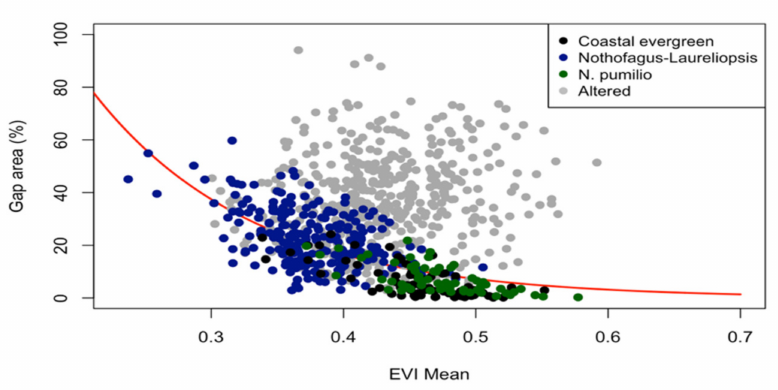
Figure 3. The relationship between the mean EVI calculated in the Landsat grid for each forest stand studied and the gap area percentage in each cell. Blue, black, and green dots indicate data from intact forests. The red line is the best nonlinear model adjusted to data from intact